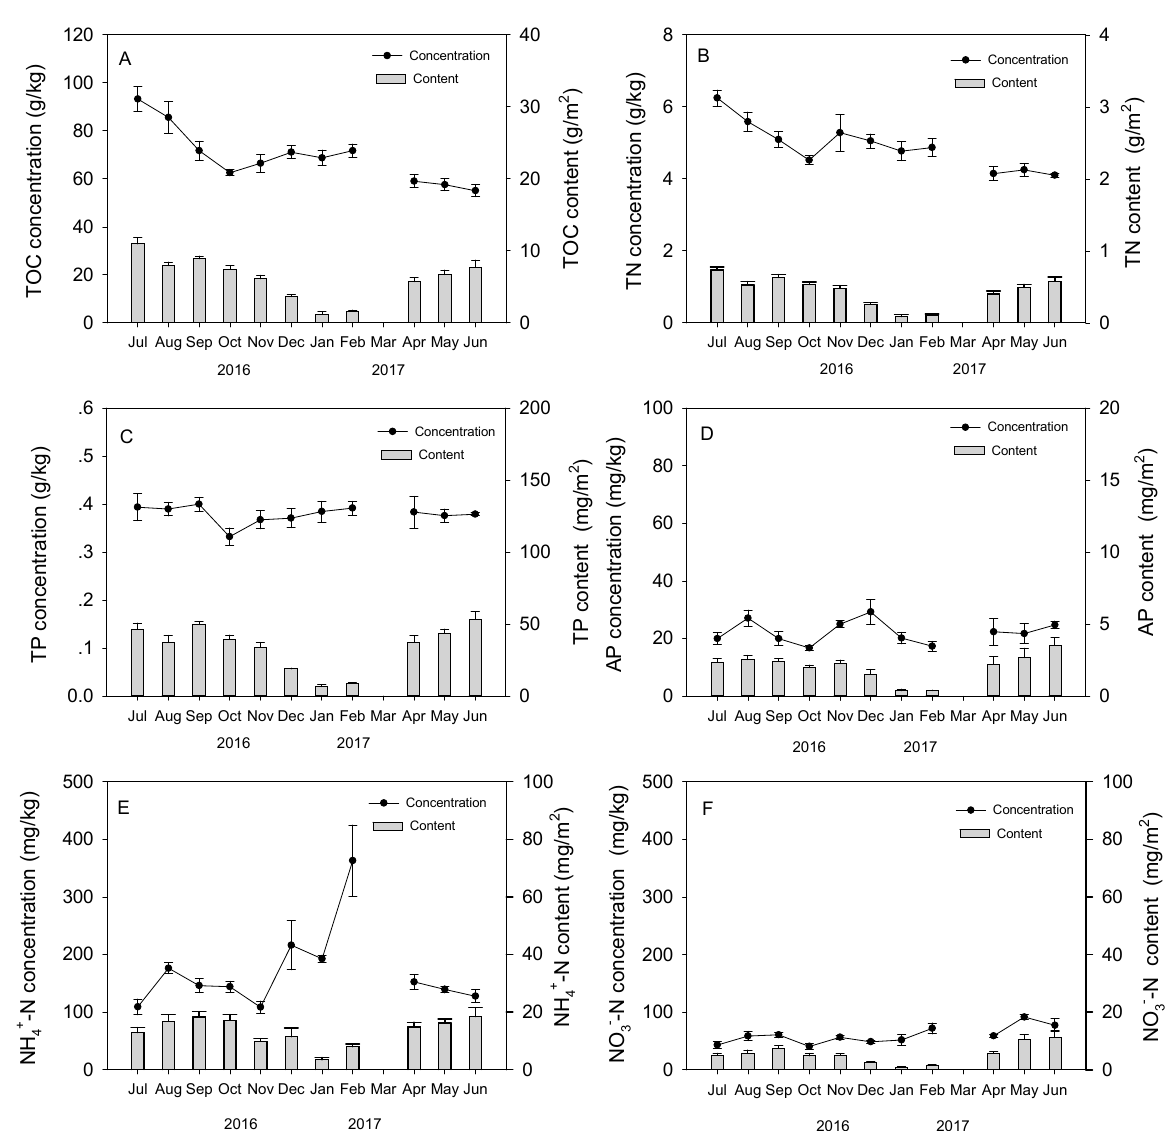
Figure 2. Monthly changes in the concentrations and contents of total organic carbon (TOC) and total and available nutrients in the earthworm surface casts: ( A ) TOC; ( B ) total nitrogen (TN); ( C ) total phosphorus (TP); ( D ) available phosphorus (AP); ( E ) ammonium nitrogen (NH 4 + -N) and ( F ) nitrate nitrogen (NO 3 − -N). Data are shown as means ± SE, n = 5. Cast production in March 2017 was too low to be measured.